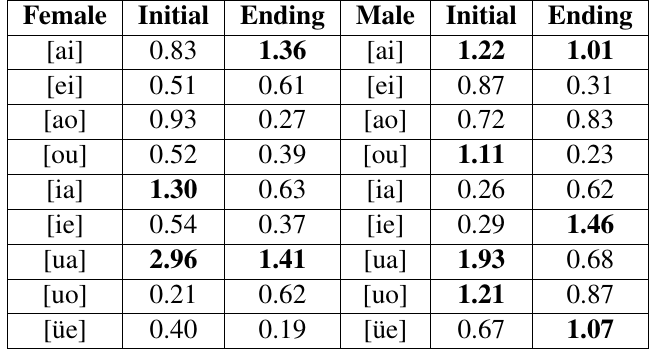
Table 3 Euclidean distance between intermediate learners and standard